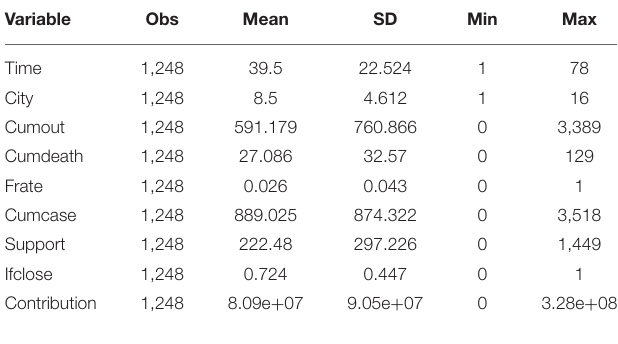
TABLE 3 | Descriptive statistics for the variables.